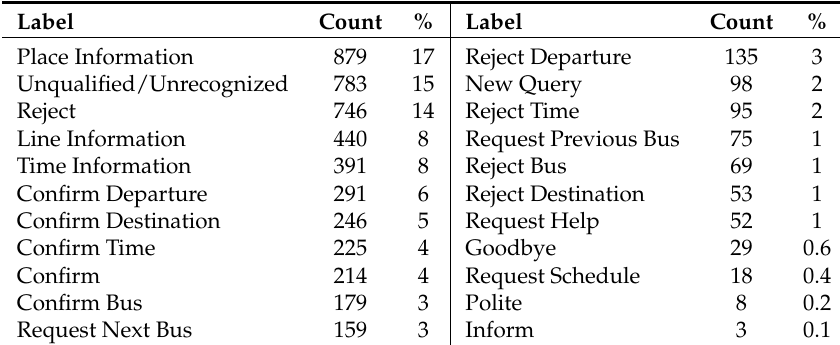
Table 2. Label distribution in the user segments of the LEGO